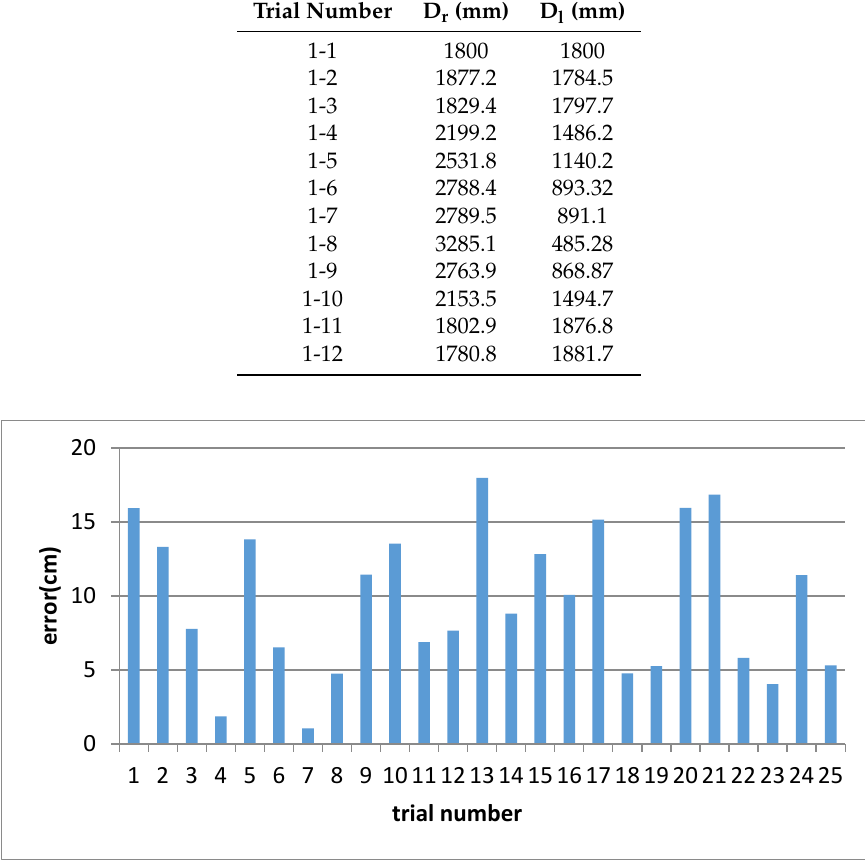
Figure 9. The lateral error of vehicle to the lanes.